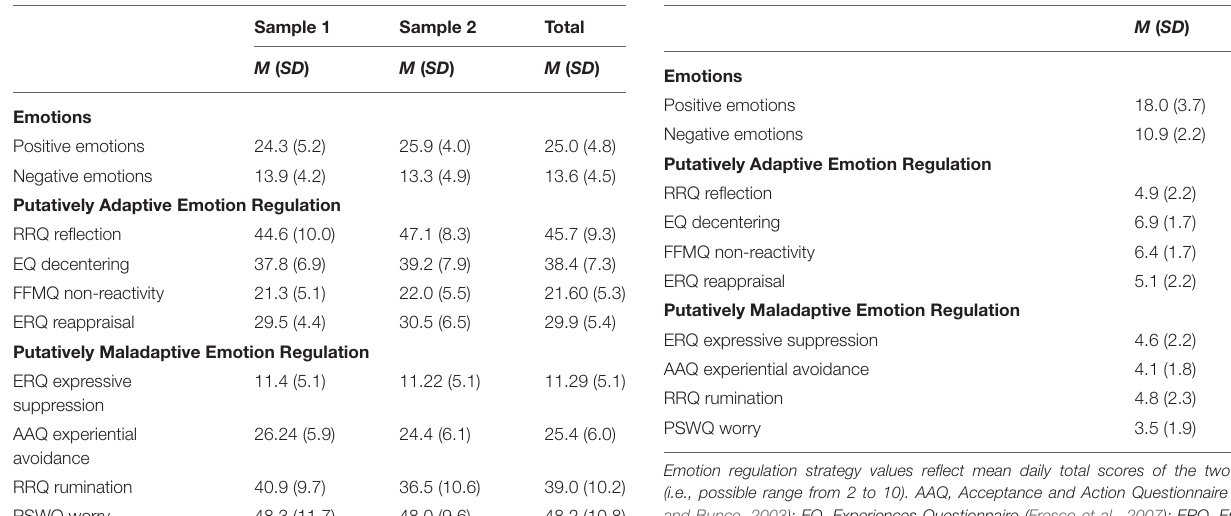
TABLE 4 | Participant descriptive statistics ( N = 90). TABLE 5 | Mean total scores for daily emotions and emotion regulation